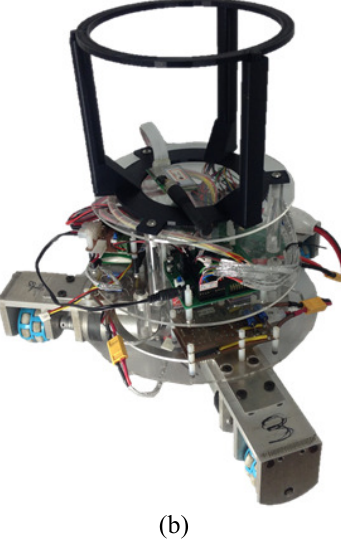
Figure 10. Omni-directional wheeled mobile